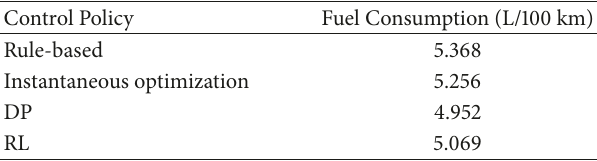
Table 2: Simulation results based on ECE